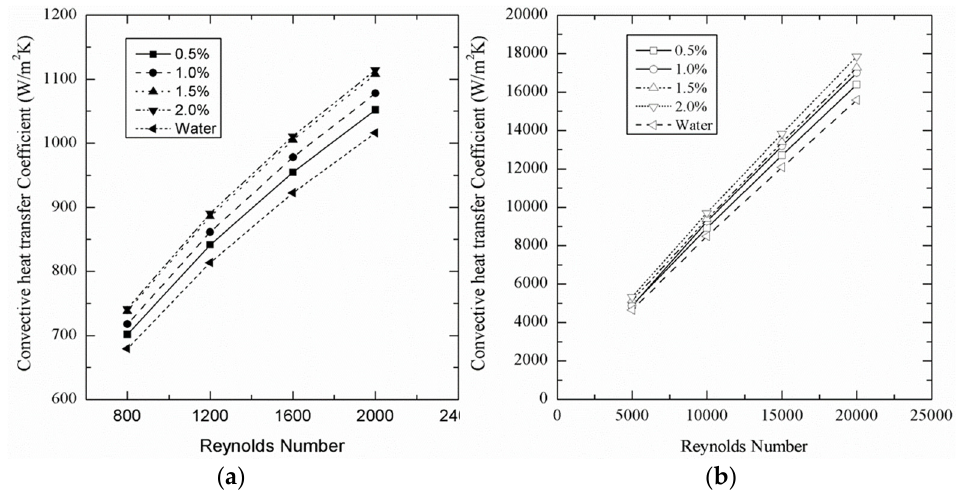
Figure 5. Average h conv with Re for Cu–Water nanofluid. ( a ) Laminar condition. ( b ) Turbulent